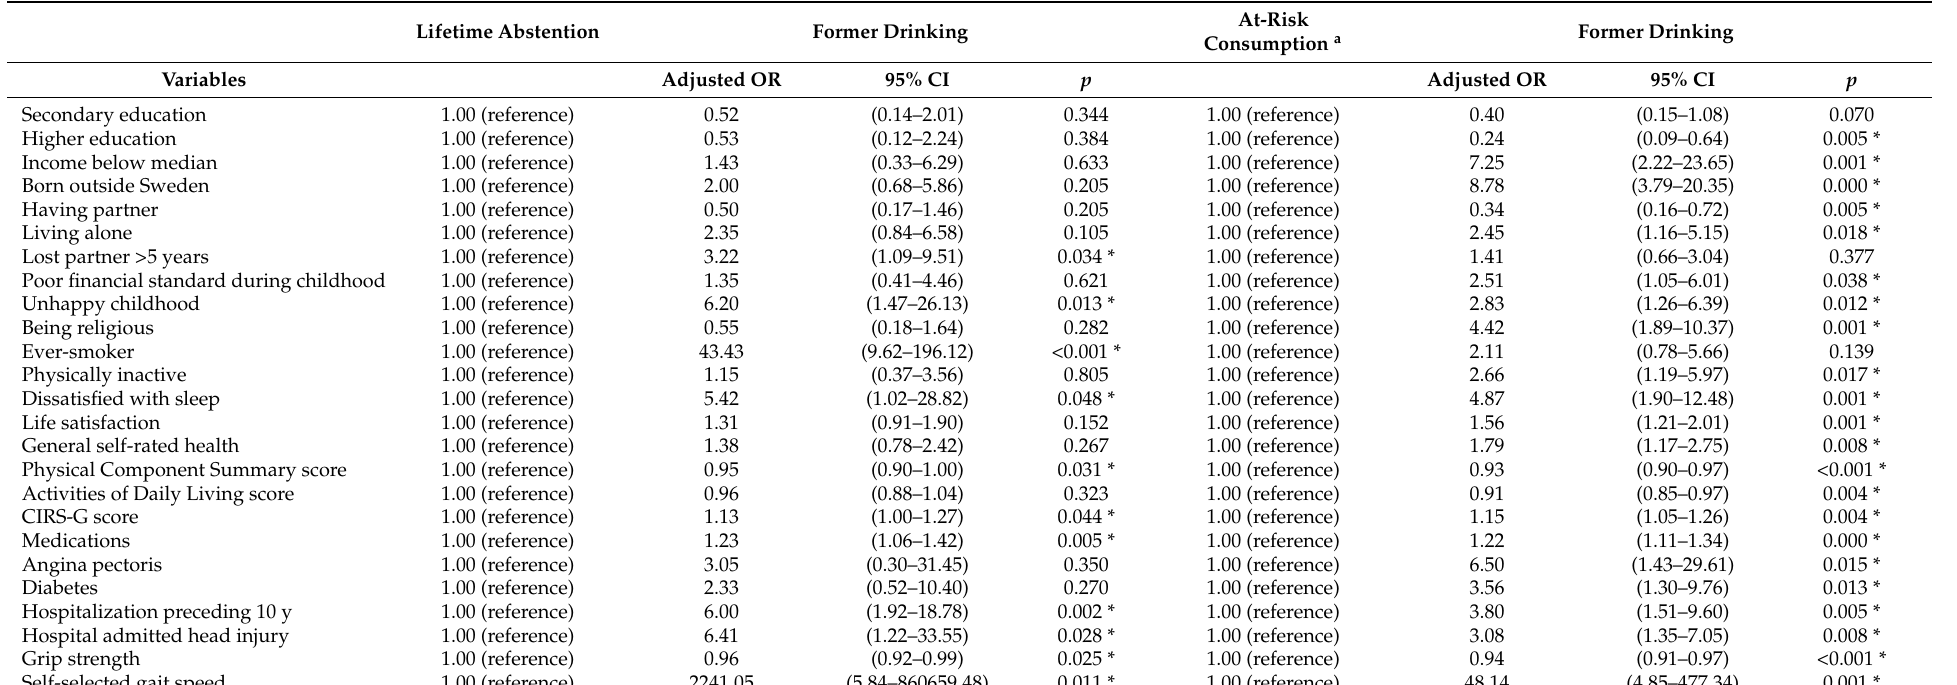
Table 6. Sociodemographic, social, and health-related factors associated with former